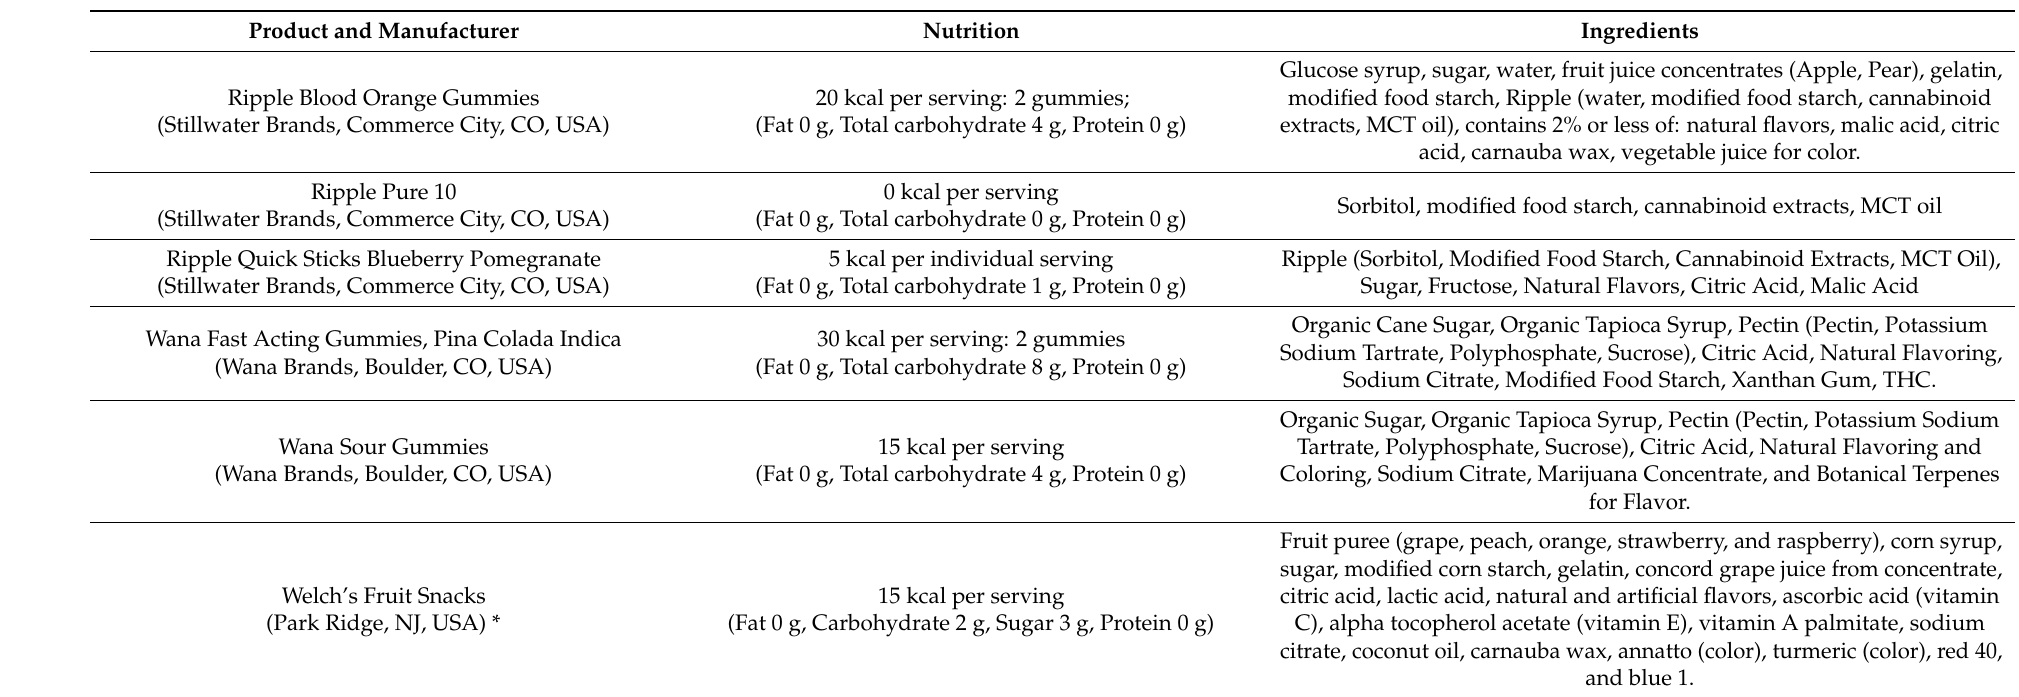
Table 2. Features of the commercially available edible marijuana